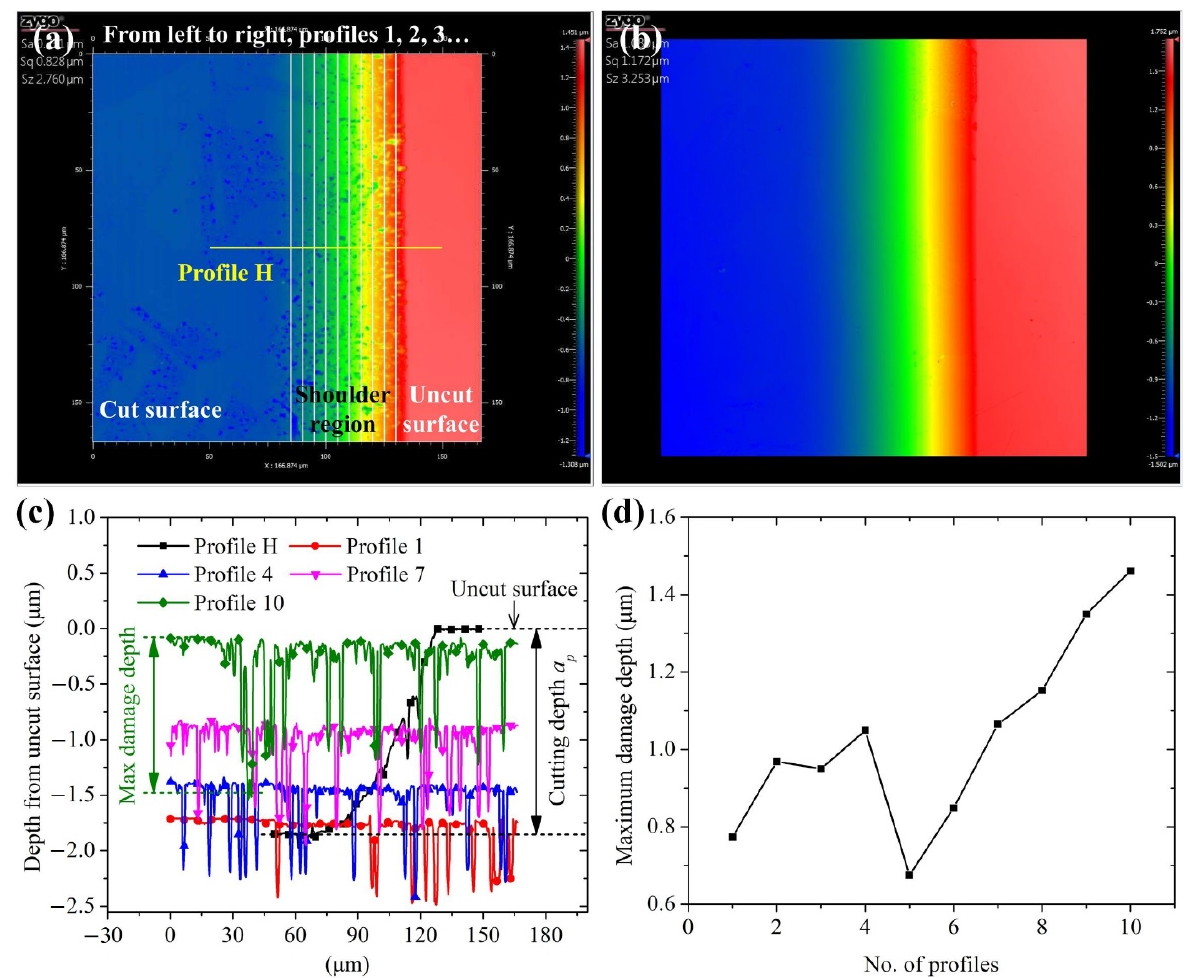
Figure 5. Damage morphologies in shoulders ( a ) 3 and ( b ) 5 cut by tool 1 under group A; ( c ) repre- sentative profiles from ( a ); ( d ) maximum damage depths for ten profiles